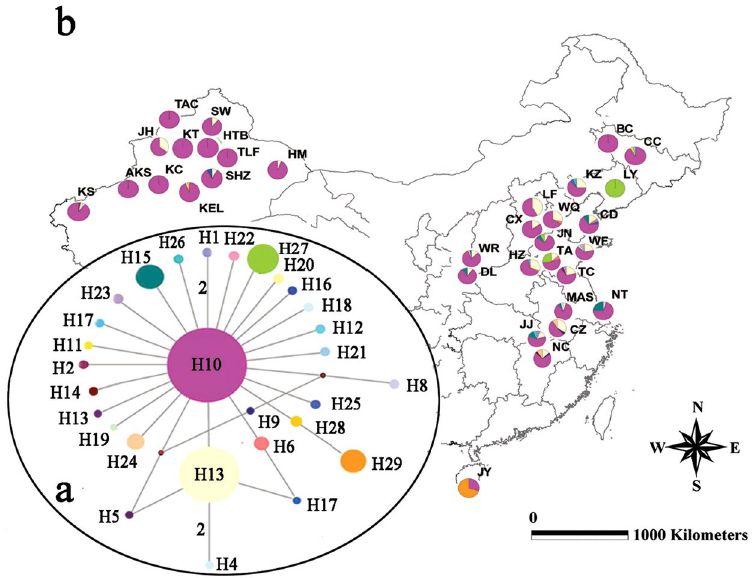
Figure 2. MtDNA haplotype network and haplotype frequencies in the examined populations of Aphis gossypii . ( a ) Haplotype network based on combined COI and Cytb sequences. Each haplotype was represented by a circle and identified by the codes H1–H29. The sizes of circles are proportional to the haplotype frequencies. Small red circles represent internal (unsampled) nodes. The median-joining network of the haplotypes of the combined COI and Cytb were generated by Network 2.0. ( b ) Haplotype frequencies and distribution in 33 populations. The color of each haplotype was the same as the network. For population abbreviations, see Table 2. ArcView GIS (version 3.2, http://www.resources.esri.com) was used to produce a distribution map based on the geographical coordinates of the localities. The base map (Greater China 1: 4,000,000) for the analysis was obtained the URL: